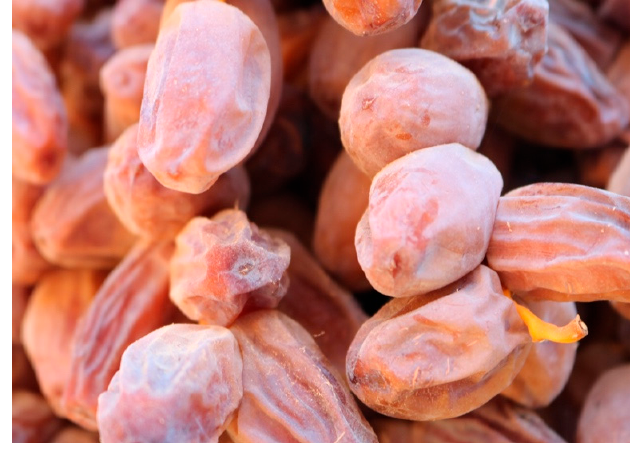
Figure 6. Sample of Al-husseiniya dates.